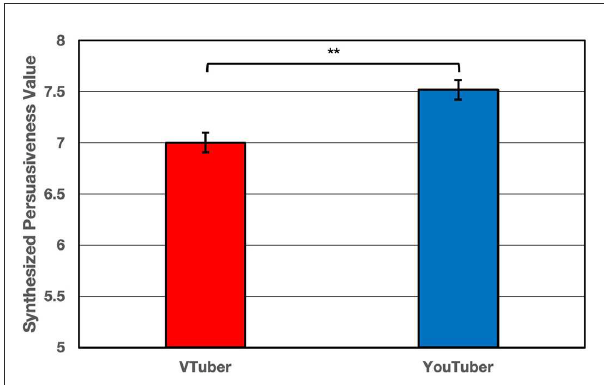
FIGURE4 Differences in synthesized persuasiveness between VTubers (virtual YouTubers) and YouTubers. ** p <